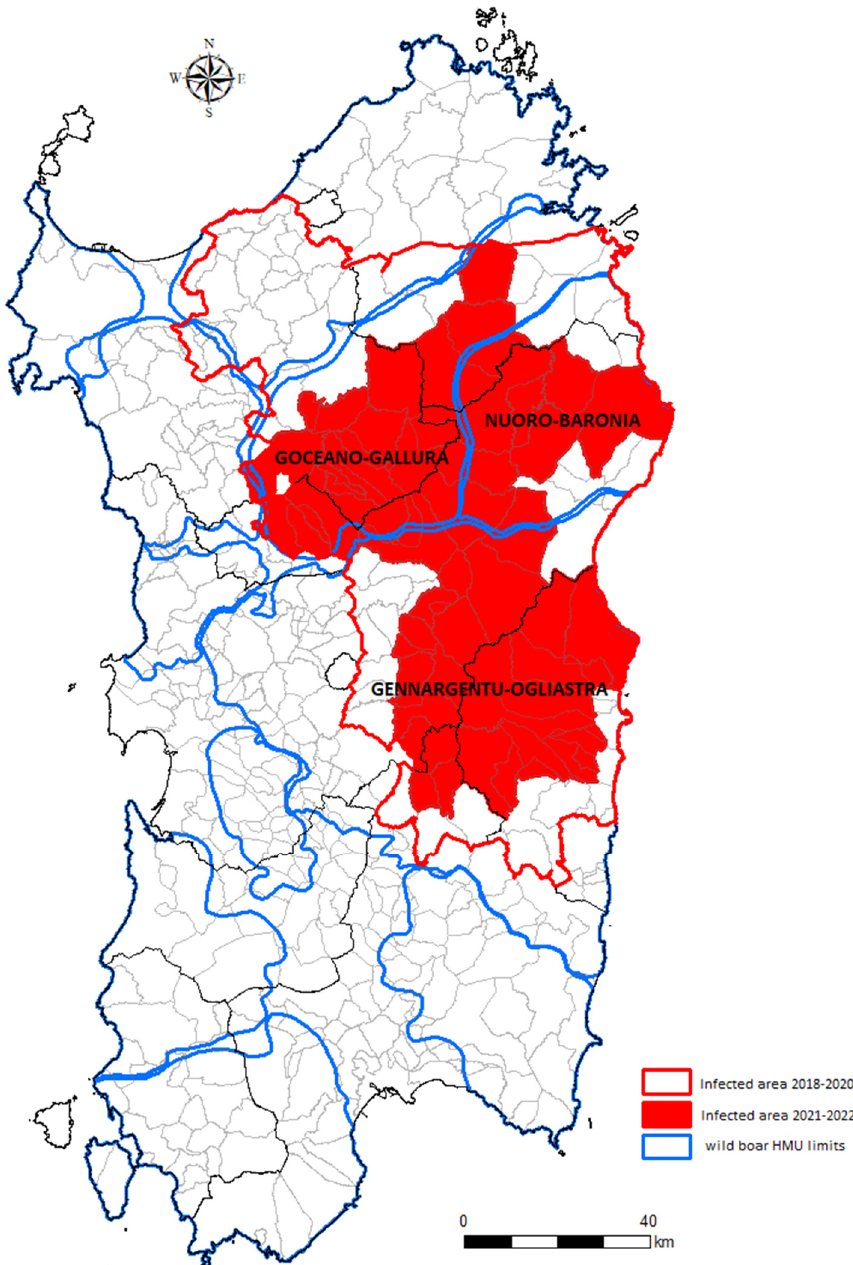
Figure 1. Map showing the limits of the wild boar hunting management units (HMUs), including the Sardinian wild boar infected area. Red outline indicates the old infected area (2018–2020), while the full red area indicated the new 2021–2022 infected area.